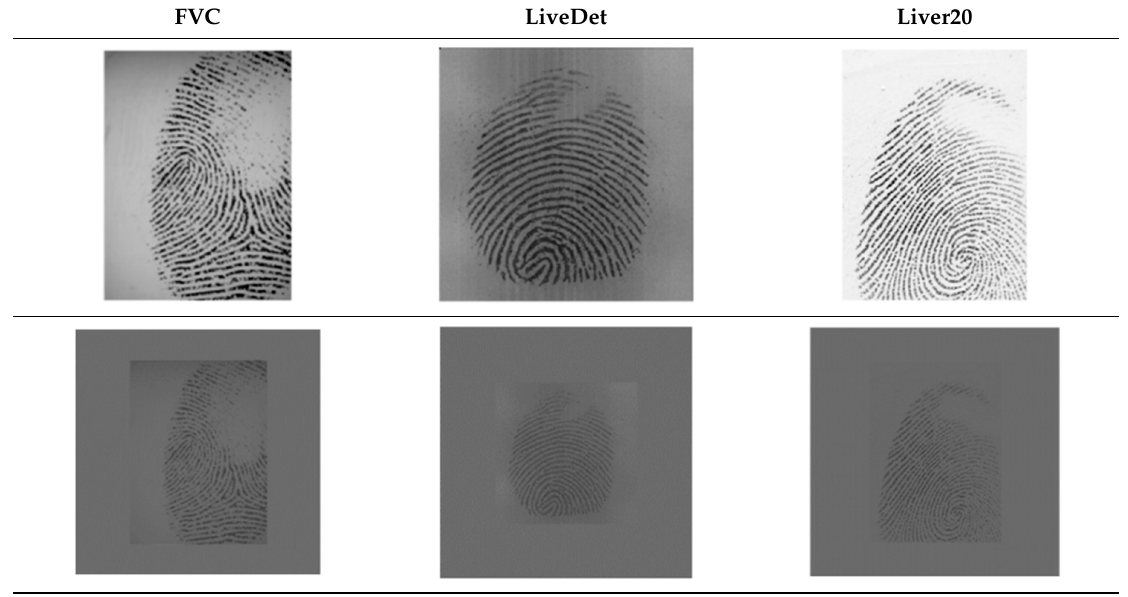
Figure 2. Original fingerprint image and data augmentation.